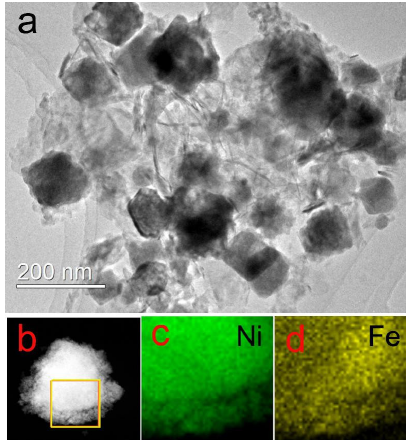
Figure 1. ( a ) TEM image of the NiFe/GO composite and ( b – d ) element mapping of the NiFe alloy.